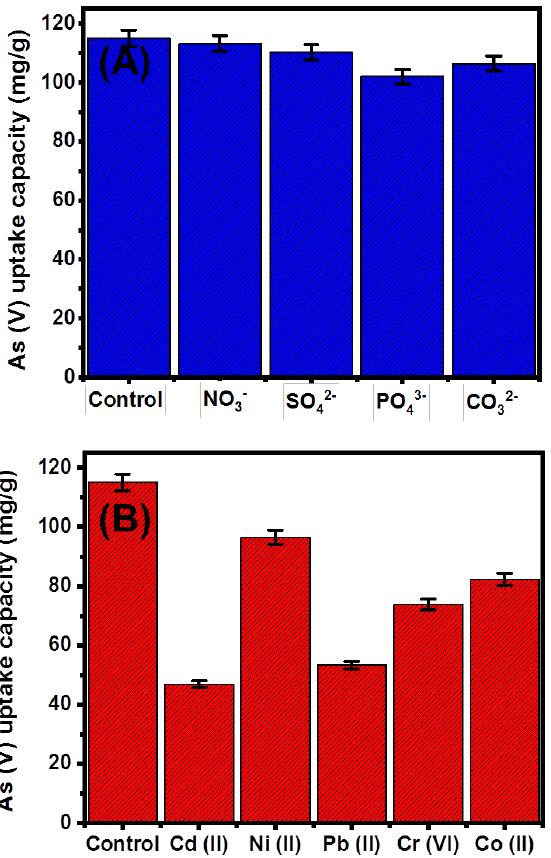
Figure 9. Effect of the competitive chemical anions ( A ) and metal ions ( B ) on the retention capacity of As (V) ions by G.Zn@PN/BE.